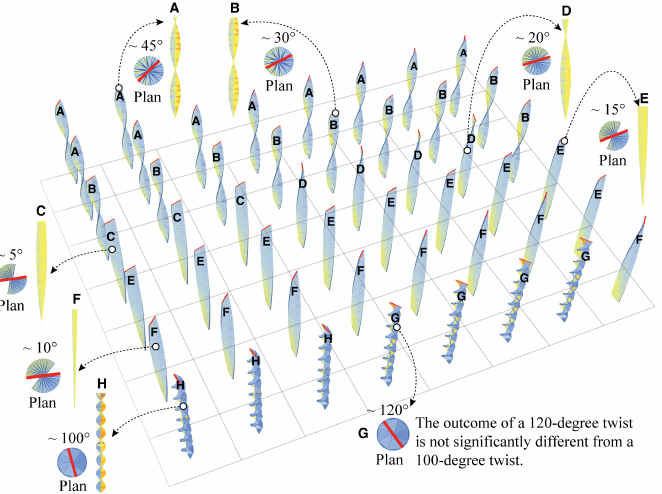
Figure 8. Overall generation of the strip phenotype in 450 solutions and the trend of SD. ( a ) the trend of SD in eight generations; ( b ) the mean value trendline of the strip forms.